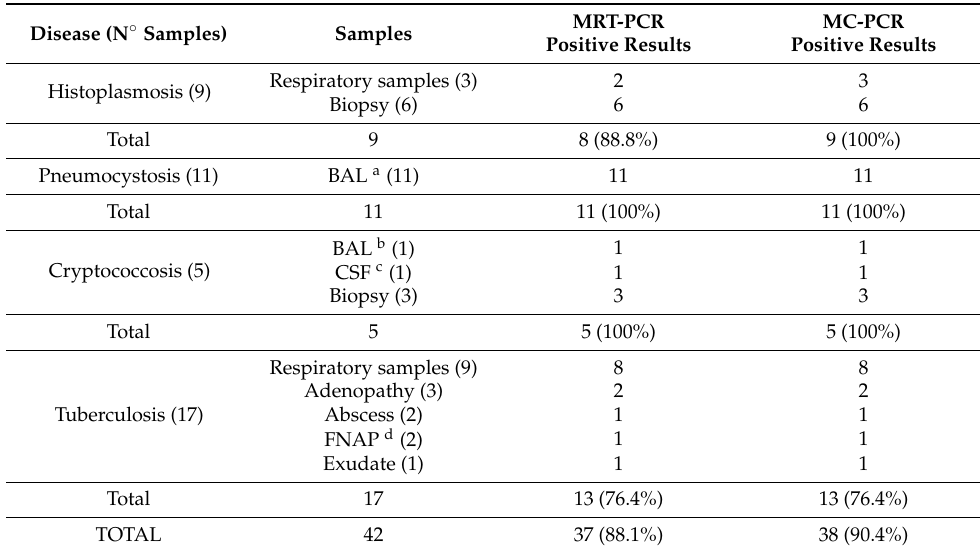
Table 3. MRT-PCR (multiplex real-time PCR) and MC-PCR (melting curves PCR) results for clinical samples from patients with fungal opportunistic pneumonia and TB.